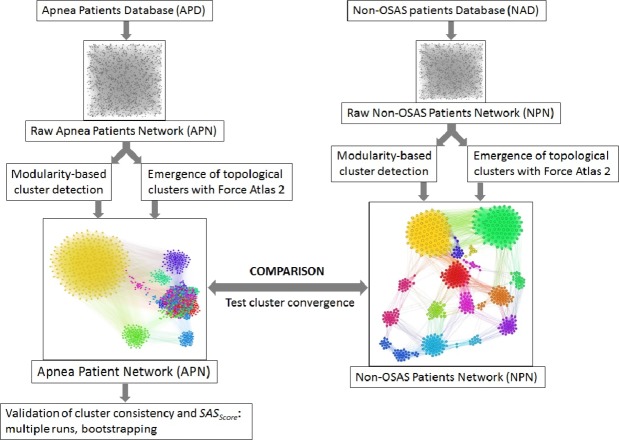
Overview of the proposed dual clustering methodology (modularity classes represented with distinct colors and topological clusters emerged from running the force directed layout Force Atlas 2), along with testing cluster formation against non-OSAS control patients (i.e., showing that risk factors converge differently for OSAS and non-OSAS patients), cluster consistency and SASScore validation.